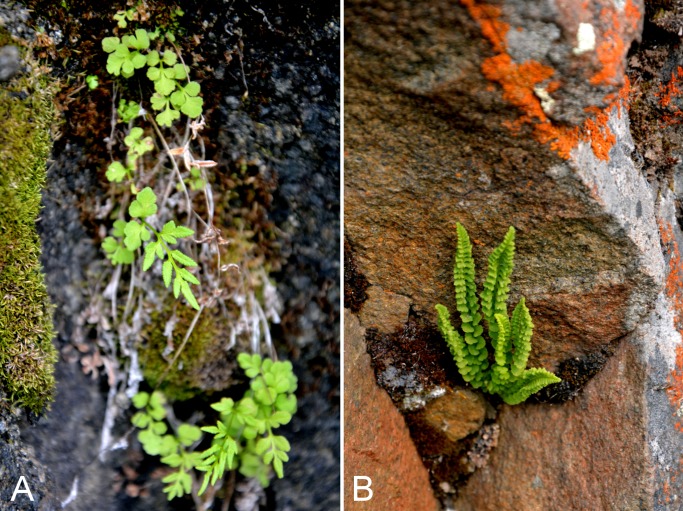
Cryptogramma stelleri and Woodsia glabella.Cryptogramma stelleri: (A) habit, Saarela et al. 4076. Woodsia glabella: (B) habit, Saarela et al. 3891. Photographs by P. C. Sokoloff.